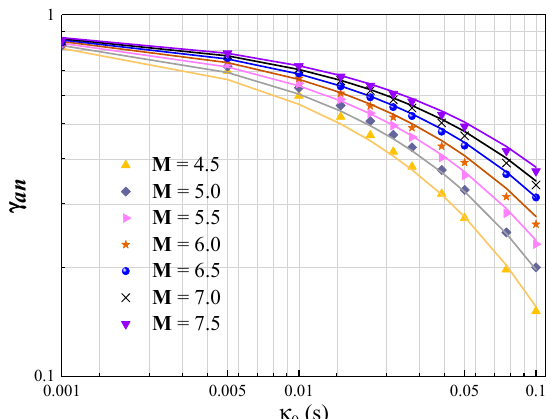
Figure 7. Regression analysis results of upper crustal attenuation factor ( γ an ).